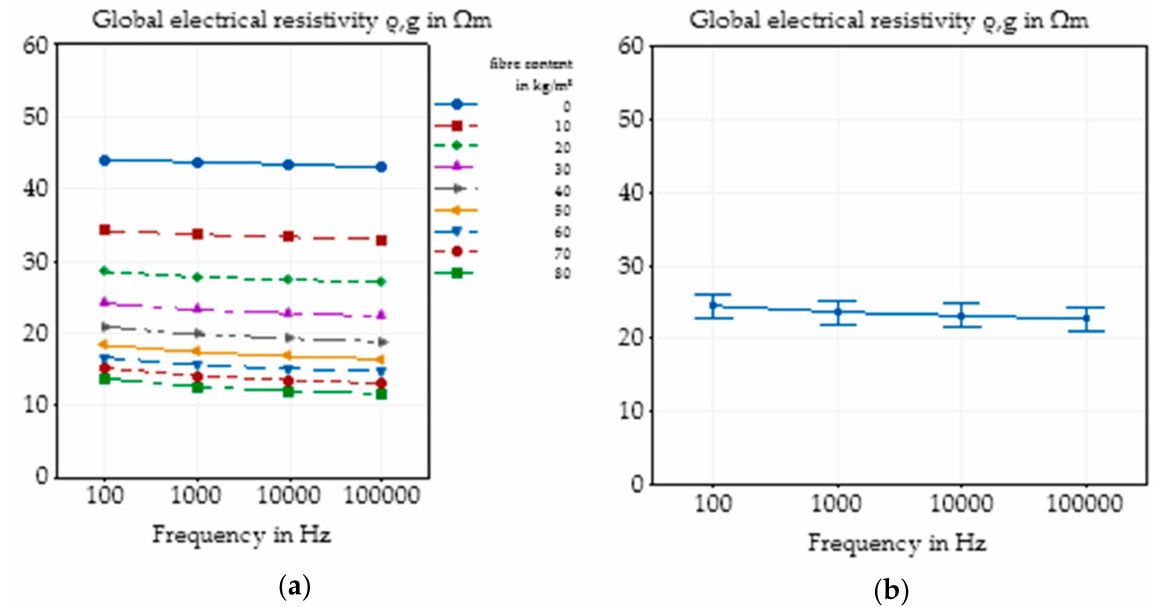
Figure 3. Effect of different frequencies of alternating current on the global electrical resistivity of SFRC as function of the fibre content in the basic concrete mixture ( a ) and main effect plot with 95% confidence interval of different frequencies of alternating current on the global electrical resistivity of SFRC calculated by Minitab based on all experimental data ( b